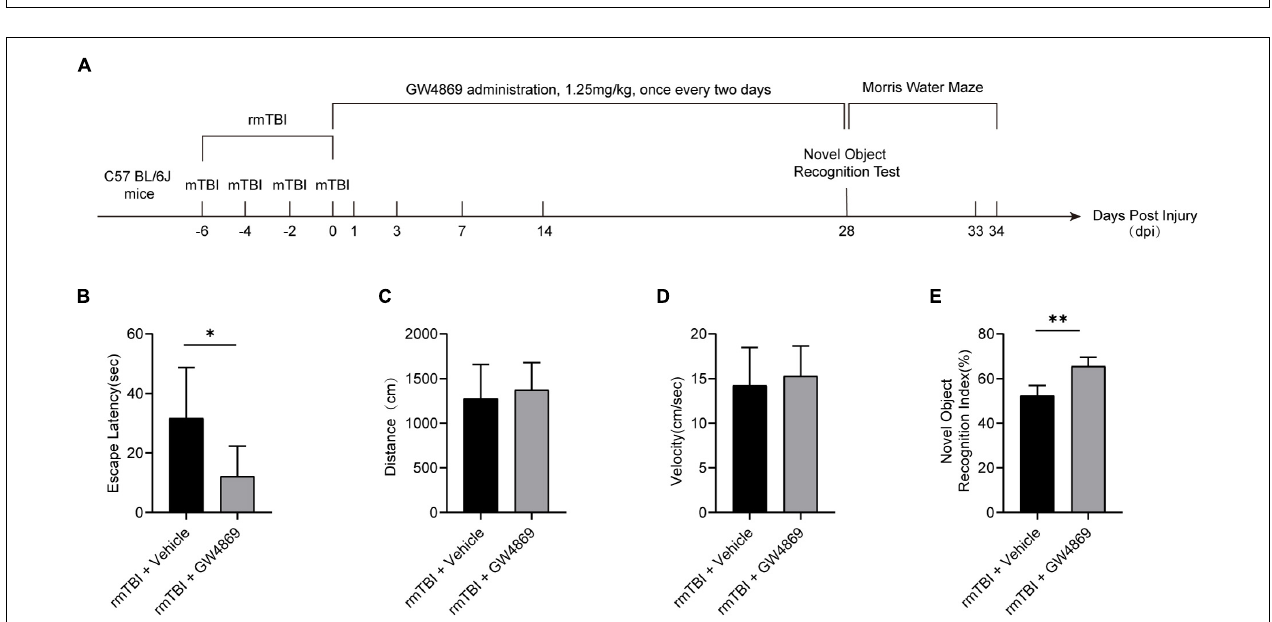
FIGURE 1 | (A,B) Quantification of exosome concentrations using nanoparticle tracking analysis. (A) The mean diameter of the particles from the Sham group was 133.1 nm, and the concentration of the particles was 3.32 × 10 8 ± 1.54 × 10 7 particles/ml. (B) The mean diameter of the particles from the rmTBI group was 121.5 nm, and the concentration of the particles was 2.21 × 10 8 ± 2.4 × 10 7 particles/ml.